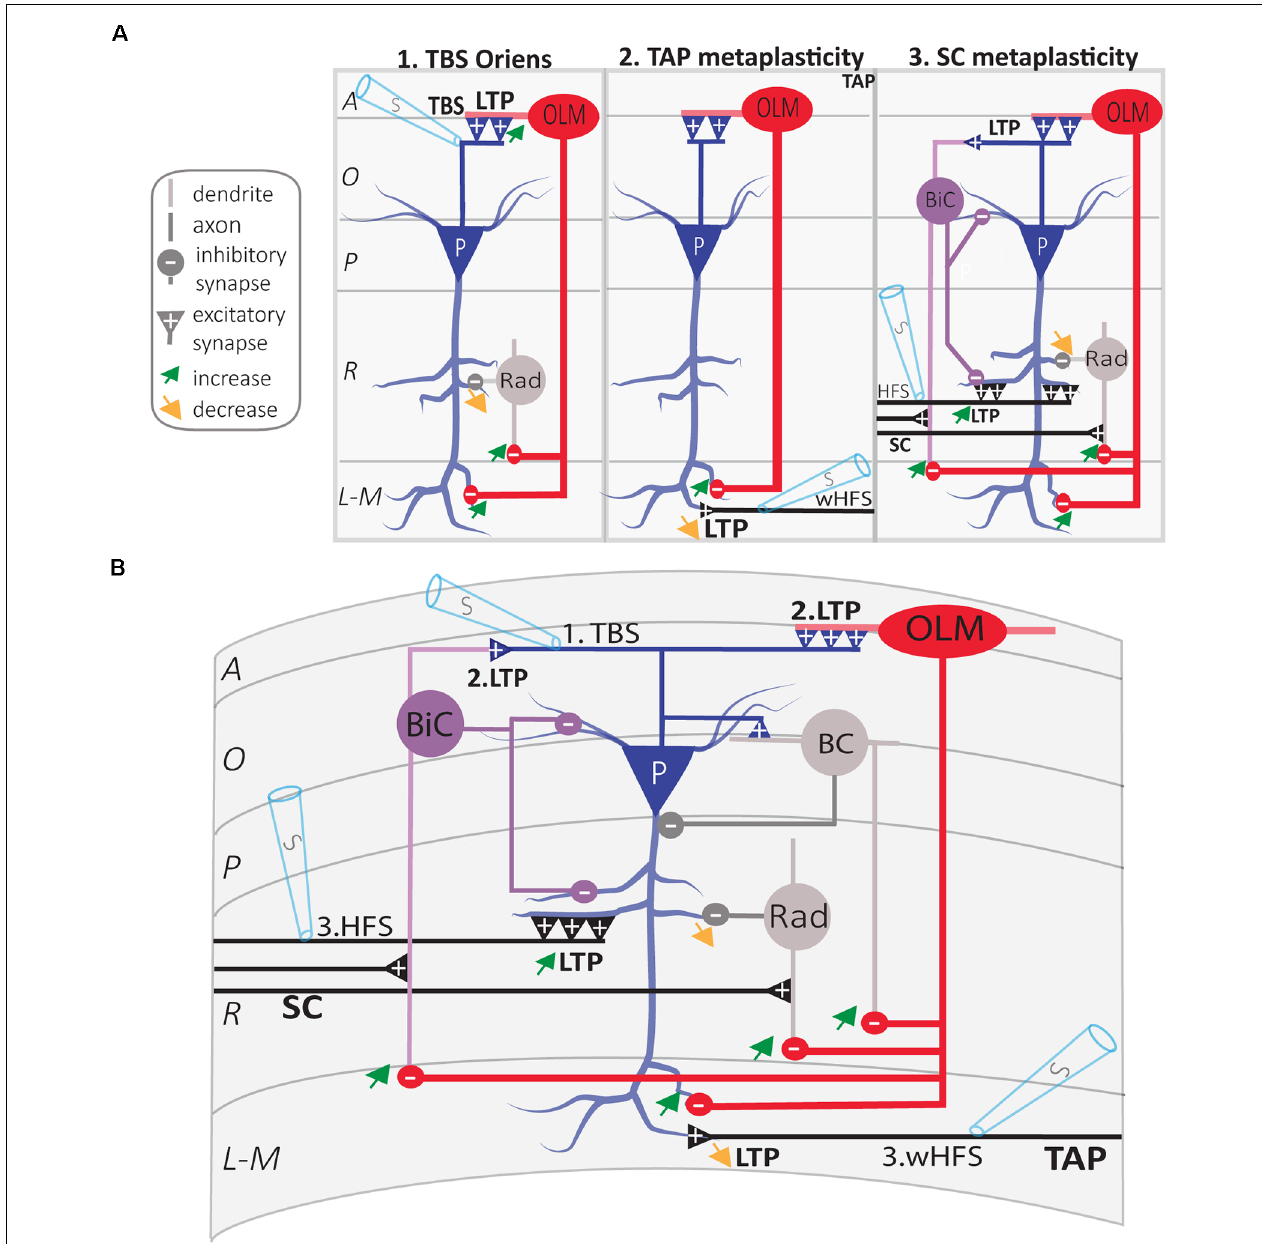
FIGURE 5 | Regulation of CA1 network metaplasticity by plasticity at excitatory synapses of SOM interneurons. (A) Diagrams of synaptic plasticity of SOM interneurons and regulation of CA1 network. (A1) Theta burst stimulation (TBS) at the O/A border induces LTP of CA1 PC synapses onto SOM interneurons (OLM cell). LTP at input synapses results in an increased firing of OLM cell, which leads to increased postsynaptic inhibition of (i) PC distal dendrites and (ii) radiatum interneurons (rad). This leads to the increased inhibition of distal dendrites in stratum lacunosum-moleculare (L-M), and disinhibition of more proximal dendrites in stratum radiatum (R). (A2) LTP of excitatory inputs of OLM cell results in TA pathway metaplasticity. Because of distal dendritic inhibition increase, tetanization of the temporoammonic (TA) pathway produces less LTP at TA-PC synapses. (A3) LTP of excitatory inputs of OLM cell results in SC pathway metaplasticity. Because of proximal dendritic disinhibition, tetanization of Schaffer collaterals (SC) produces larger LTP at SC-PC synapses. As electrically induced TBS also produces LTP at PC-BiC synapses, the overall results on BiC inhibition of PCs remain undetermined. (B) Integration of synaptic mechanisms described above: 1. TBS of PC axons; 2. LTP at PC-OLM synapses results in more inhibition of distal PC dendrites and disinhibition of proximal PC dendrites; the end-result of LTP at PC-BiC synapses on BiC inhibition of PC remains undetermined. 3. Metaplastic changes of CA1 circuit: increased LTP at SC-PC synapses and decreased LTP at TA-PC synapses. Abbreviations for CA1 layers: A, alveus ; O, oriens ; P, pyramidale ; R, radiatum ; L-M, lacunosum-moleculare. Abbreviations for CA1 afferent inputs: SC, Schaffer collateral pathway; TAP, temporo-ammonic pathway. Abbreviations for SOM cell types: (red) OLM, o riens/lacunosum-moleculare cell; (violet) BiC, bistratified cell. Abbreviations for other cell types: (blue) P, pyramidal cell; (gray) BC, basket cell; (gray) Rad, unidentified stratum radiatum interneurons. Other Abbreviation: S, stimulation electrode.